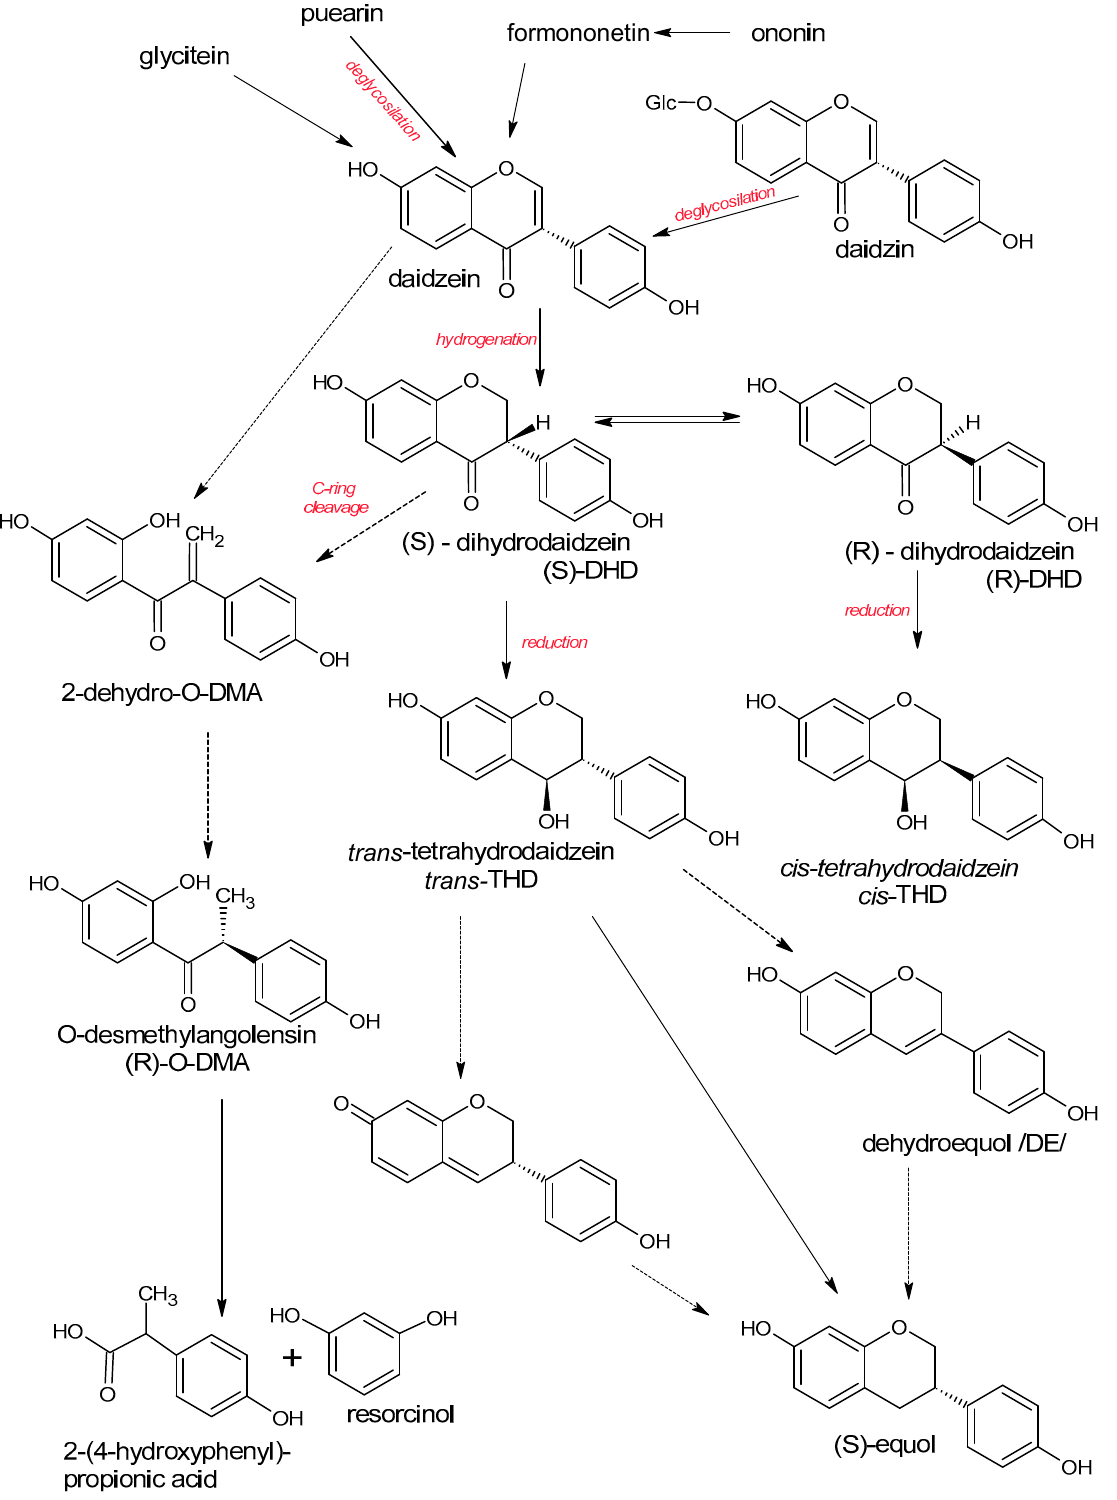
Figure 4. Possible pathways of microbial metabolism of daidzin and daidzein. Based on [236–243]. The dashed arrows indicate hypothesized reactions of microbiological degradation that were observed in vitro but were not reported in vivo.